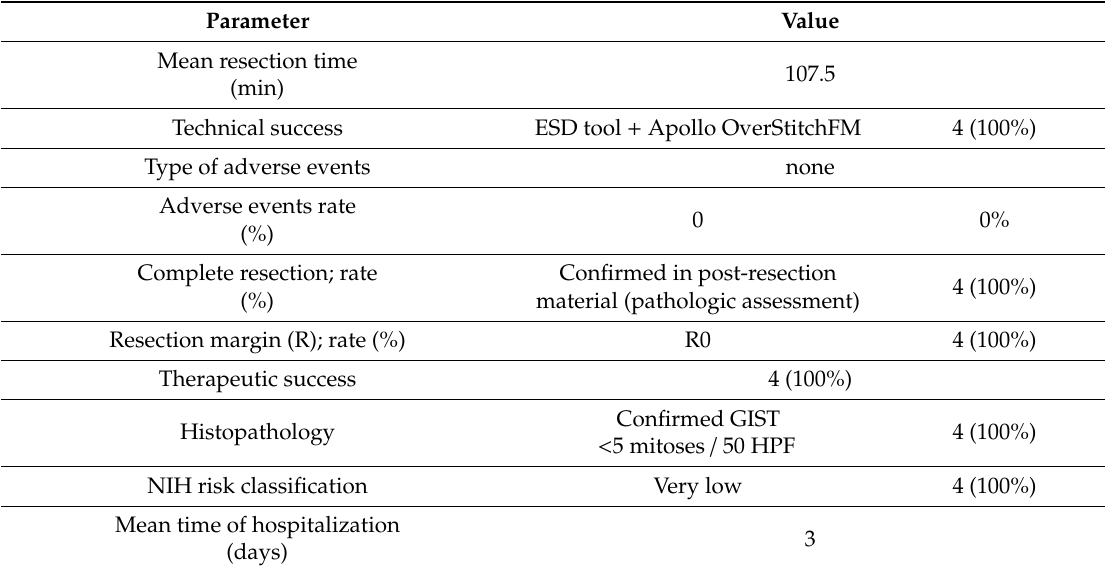
Table 2. Results of the treatment, complications,